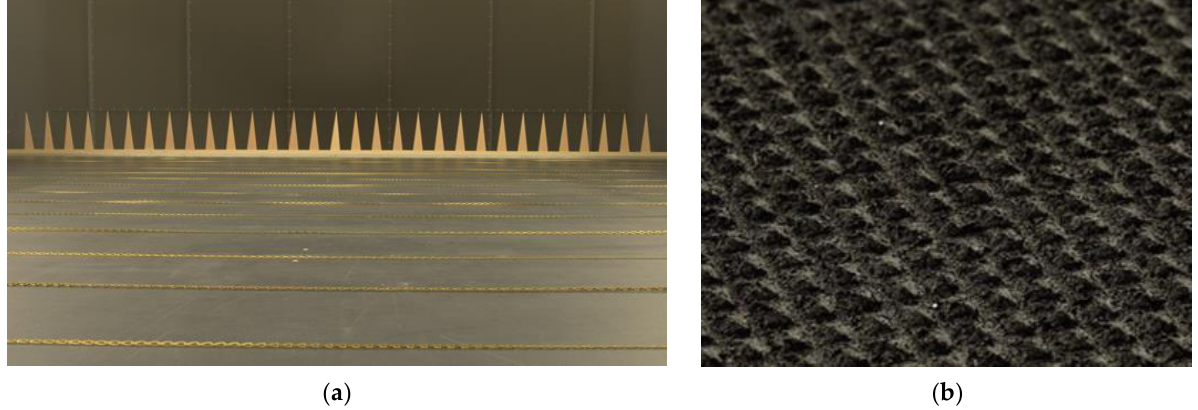
Figure 1. ( a ) Upstream view of the boundary layer development section built of spires and roughness elements; ( b ) zoomed view of the surface pyramids placed further downstream in the model section.